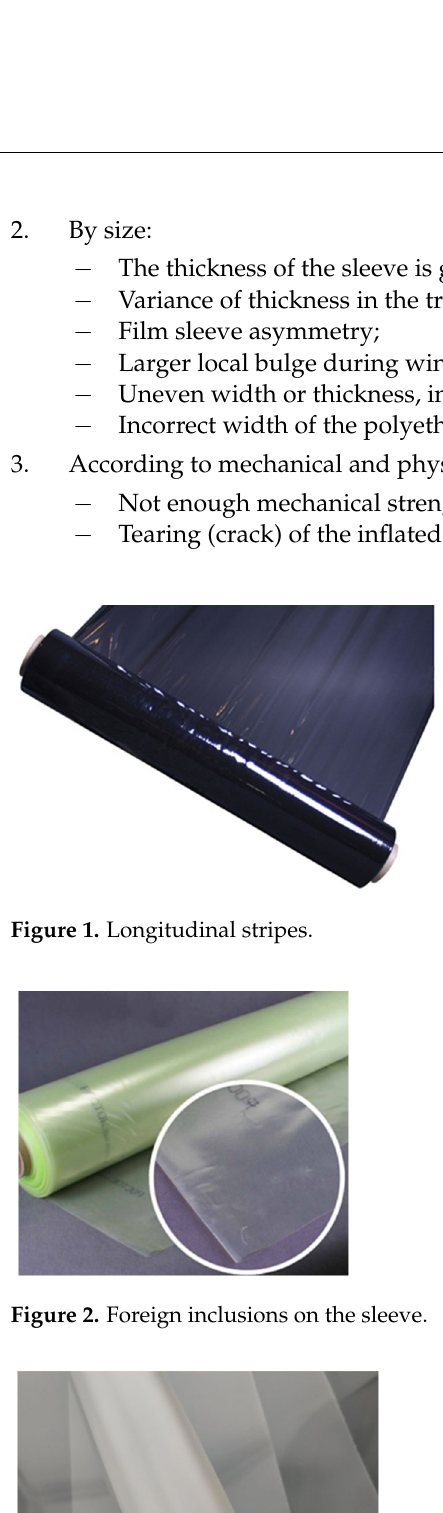
Figure 3. Dark spots.